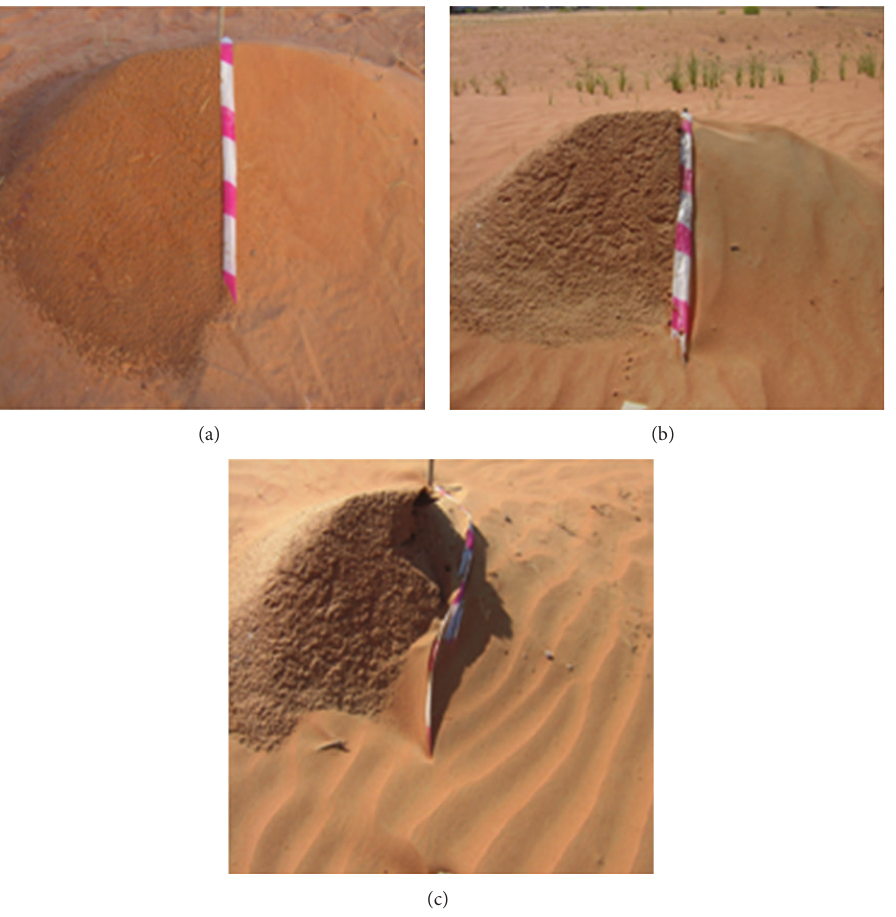
Figure 3: Shows sand erosion in a dune formation over 9-week exposure to weathering condition in Al-Ain in which the treated half is completely preserved. (a) After one week, (b) after three weeks, and (c) after nine